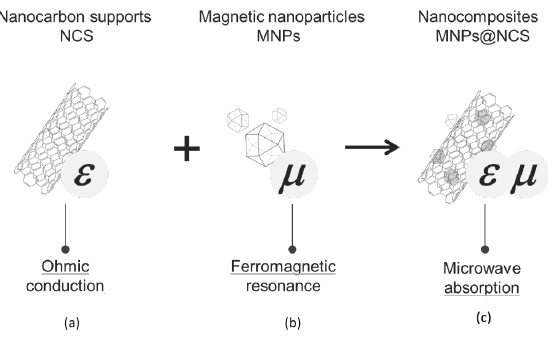
Figure 1. Strategy for controlling electromagnetic propagation: ( a ) nanocarbon support NCS (CNT or graphene) for controlling dielectric constant ε r and conductivity σ ; ( b ) magnetic nanoparticles (MNPs) for controlling permeability µ r and ( c ) combination of NCS and MNPs for improving EM performances.